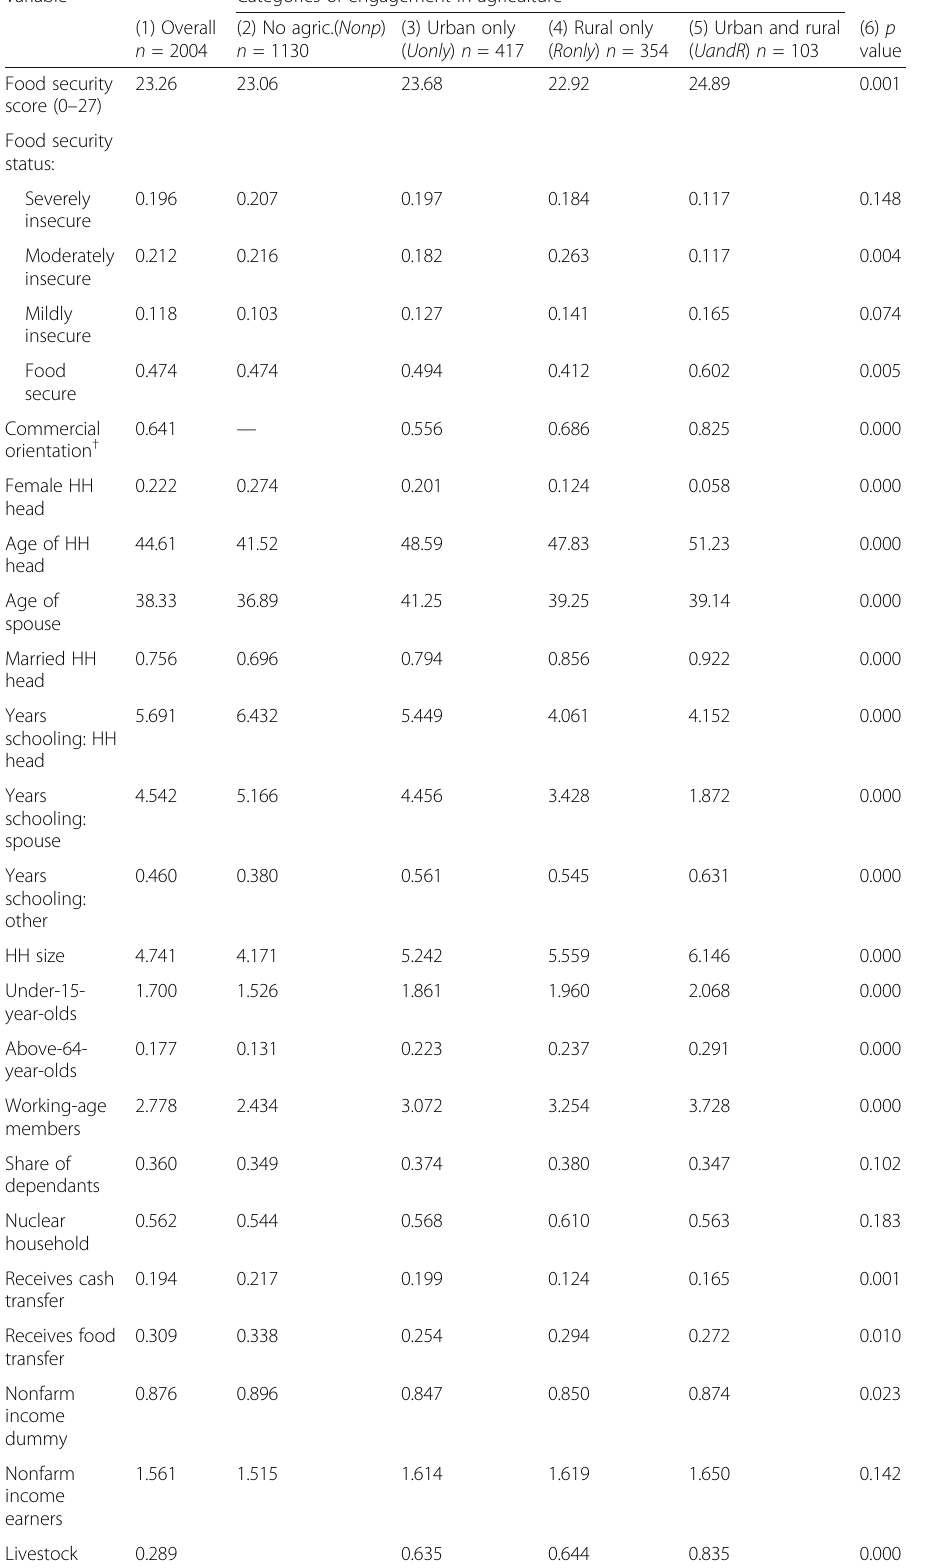
Table 2 Sample mean statistics by agricultural participation categories